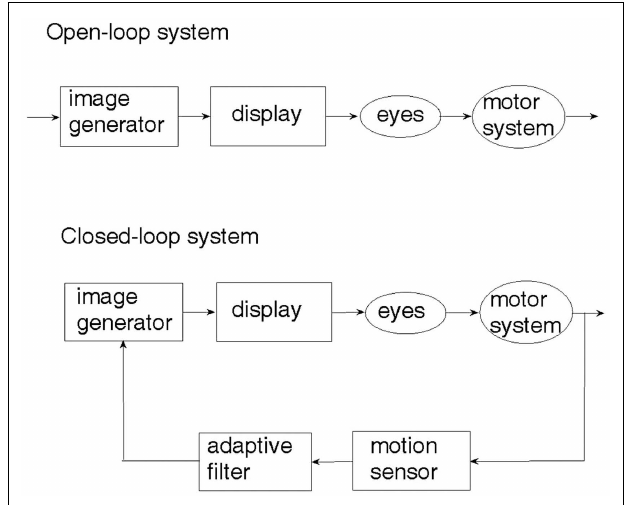
FIGURE 1 | Closed-loop vs. open-loop sensory-motor control system .